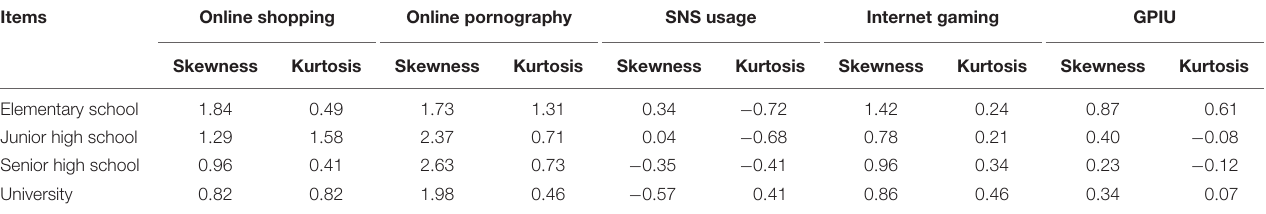
TABLE 2 | Mean, standard deviation, and Pearson’s correlation values of the studied variables. Variables